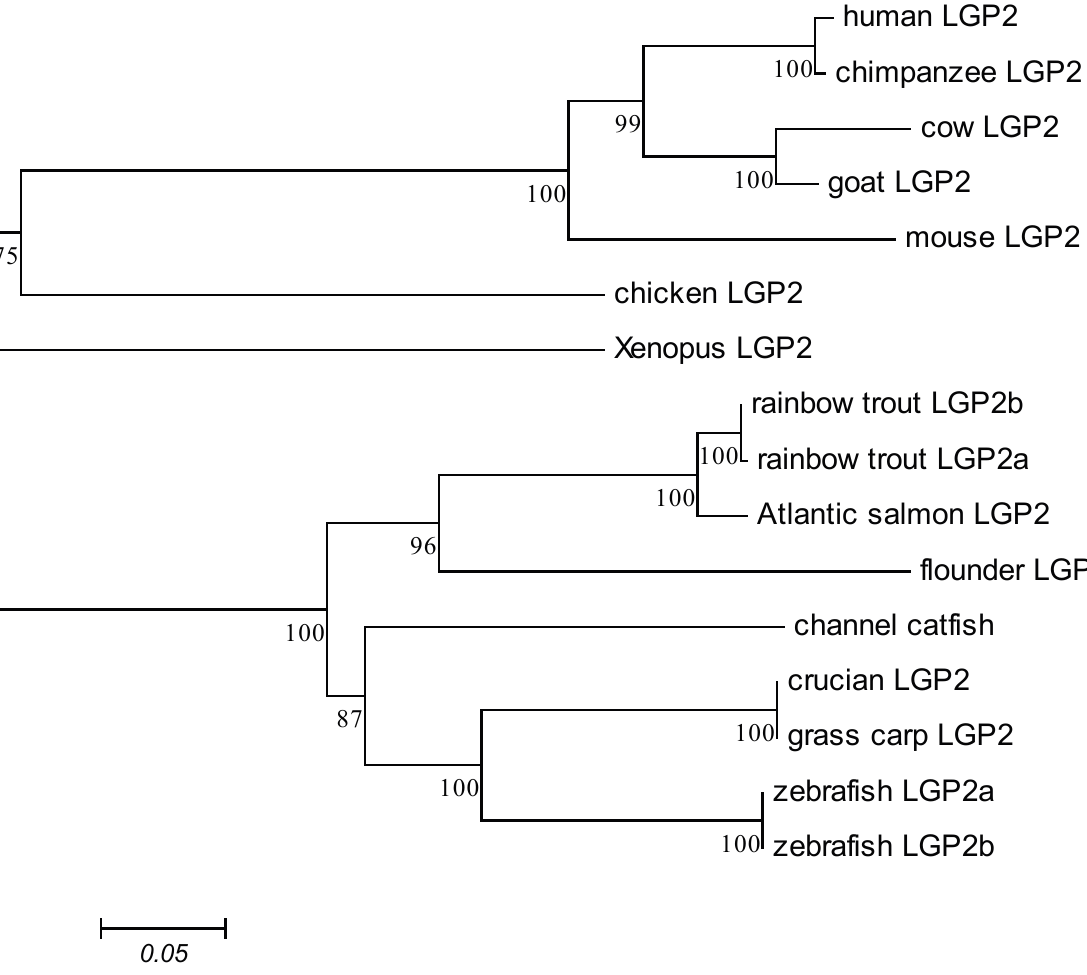
( Danio rerio , KP341002), zebrafish LGP2b